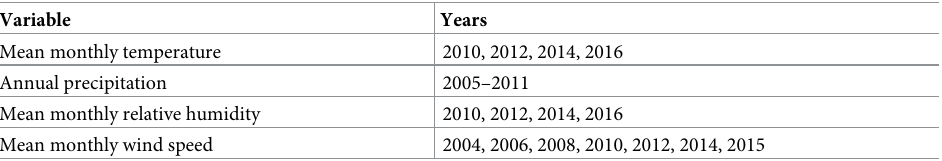
Table 3. Climate data validation variables. Description of climate variables, number of weather stations, and years for which data were acquired from the Jordan Meteorological